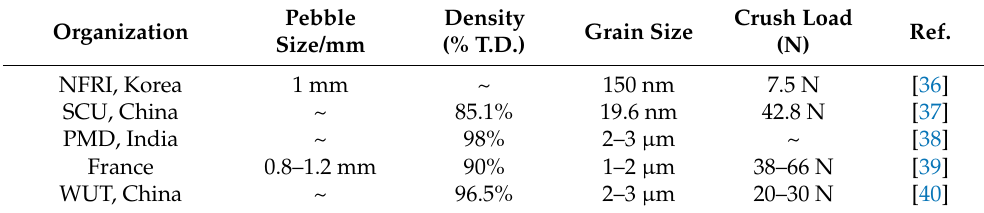
Table 2. Recent developments in the fabrication of Li 2 TiO 3 by the solid-state